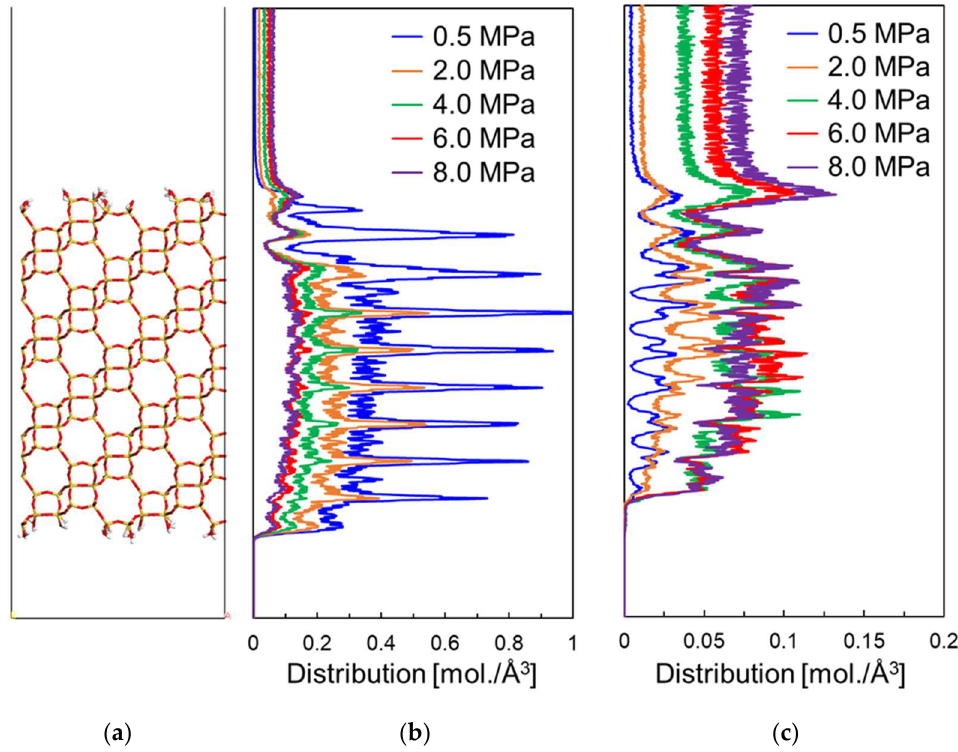
Figure 5. Concentration profile of gas molecules in the perfectly crystalline model on NEMD simu- lation at different pressure conditions. ( a ) Schematic of membrane model, ( b ) concentration profile of CO 2 , and ( c ) concentration profile of CH 4 .